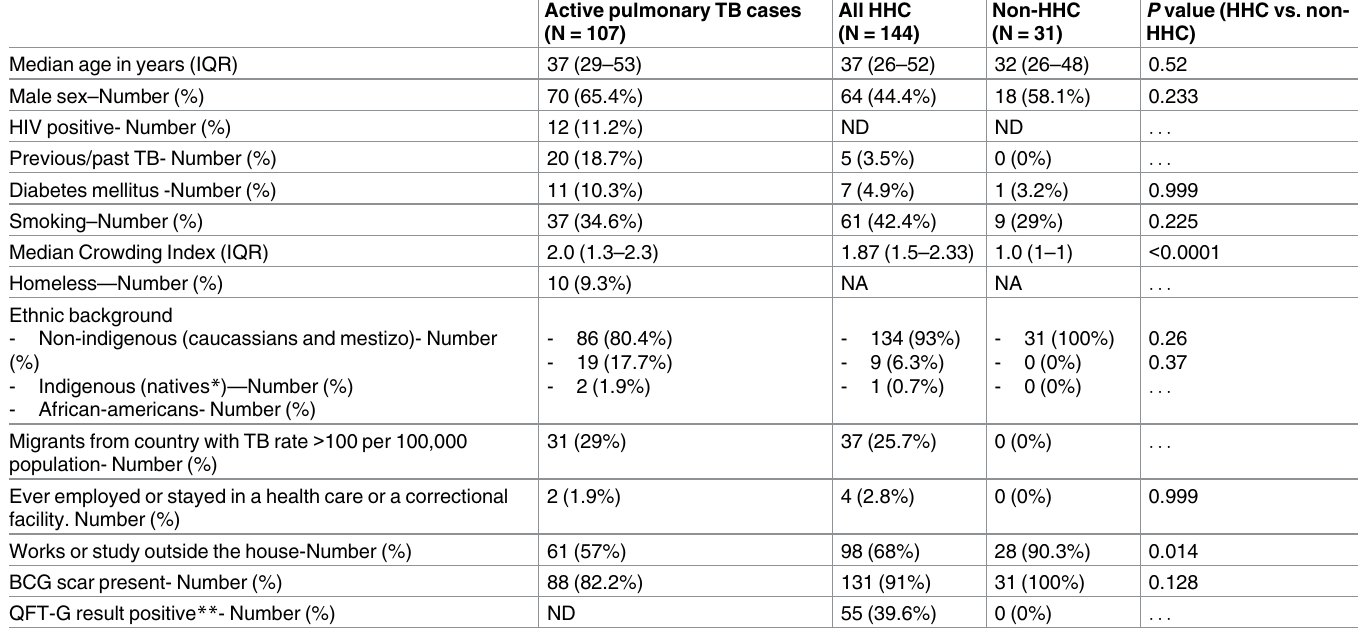
Table 1. Clinical and demographic characteristics of tuberculosis (TB) cases, household contacts (All HHC) and non-household contacts control group (Non-HHC) at